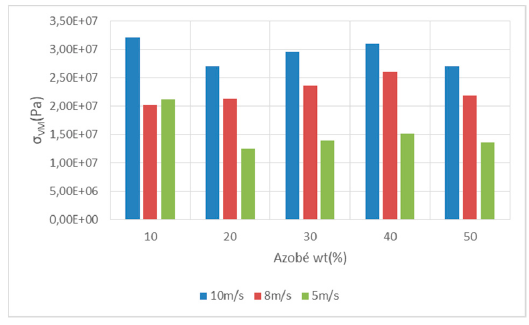
Figure 11. Equivalent stress at the center of the plate. Table 3. State of the deformations of the WPC50A composite plate observed at regular intervals of 0.4 ms for each type of impactor.